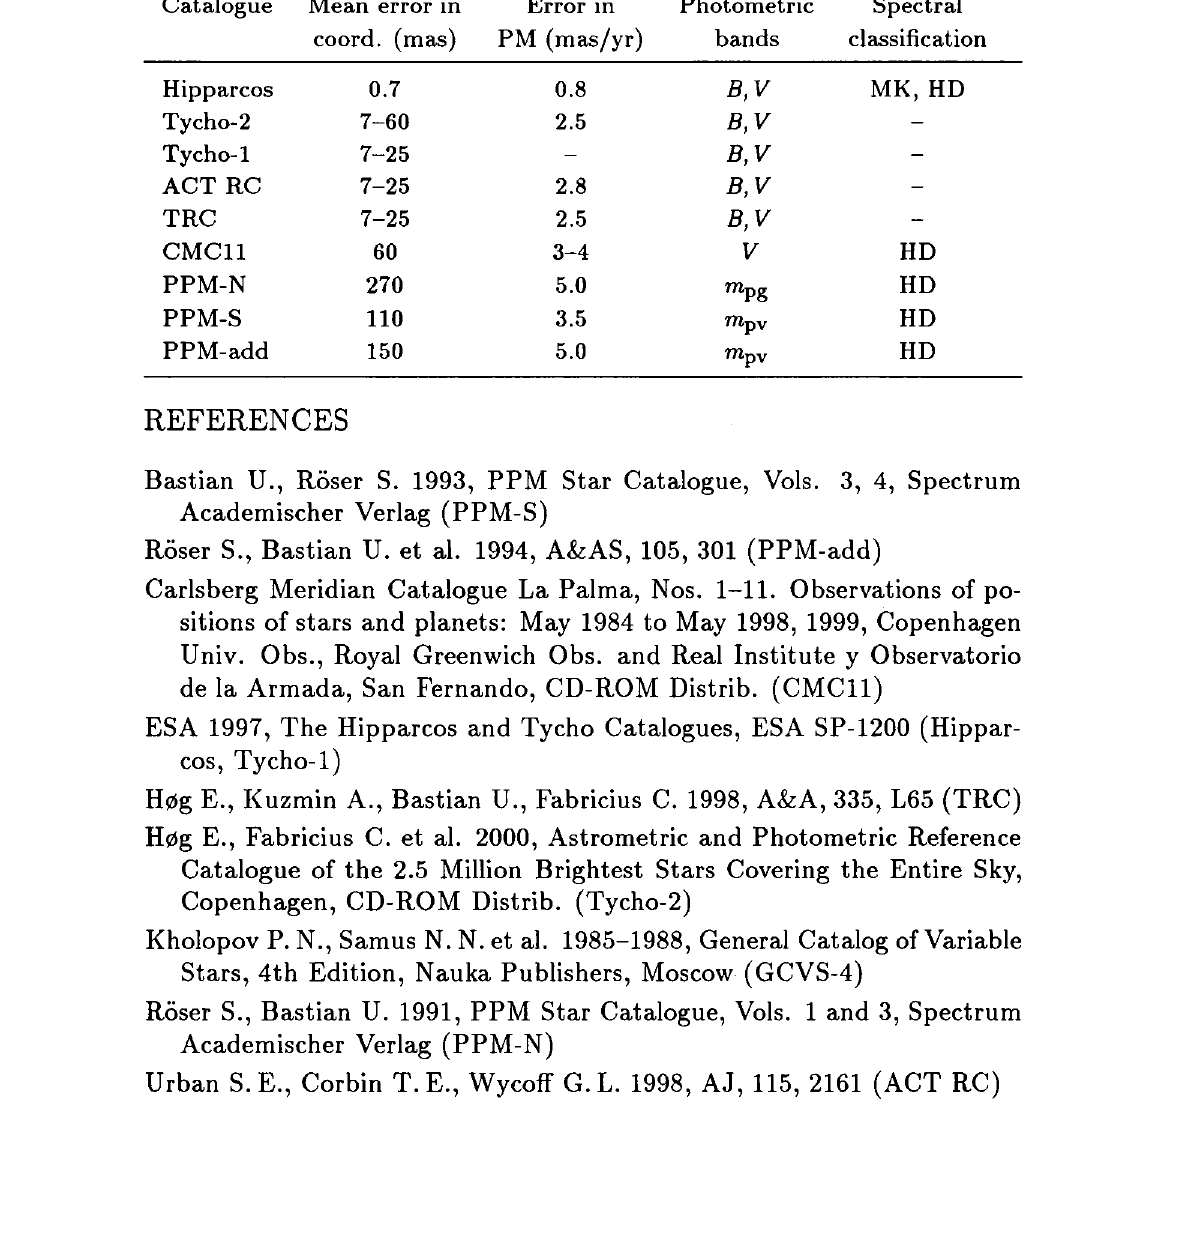
Table 1. Astrometric catalogues used for identification of